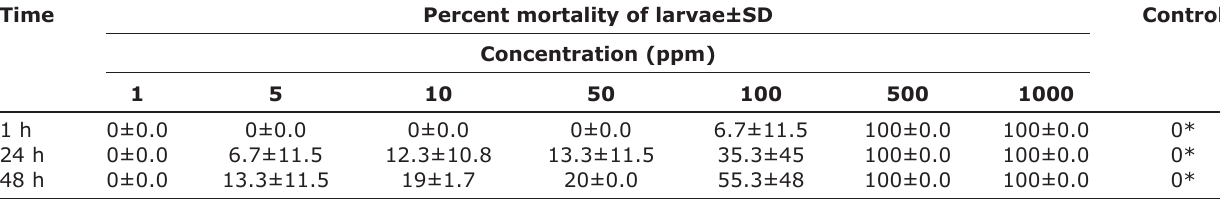
Table-1: Mortality of A. aegypti larvae using essential oil Piper betle L. Time Percent mortality of larvae±SD Control